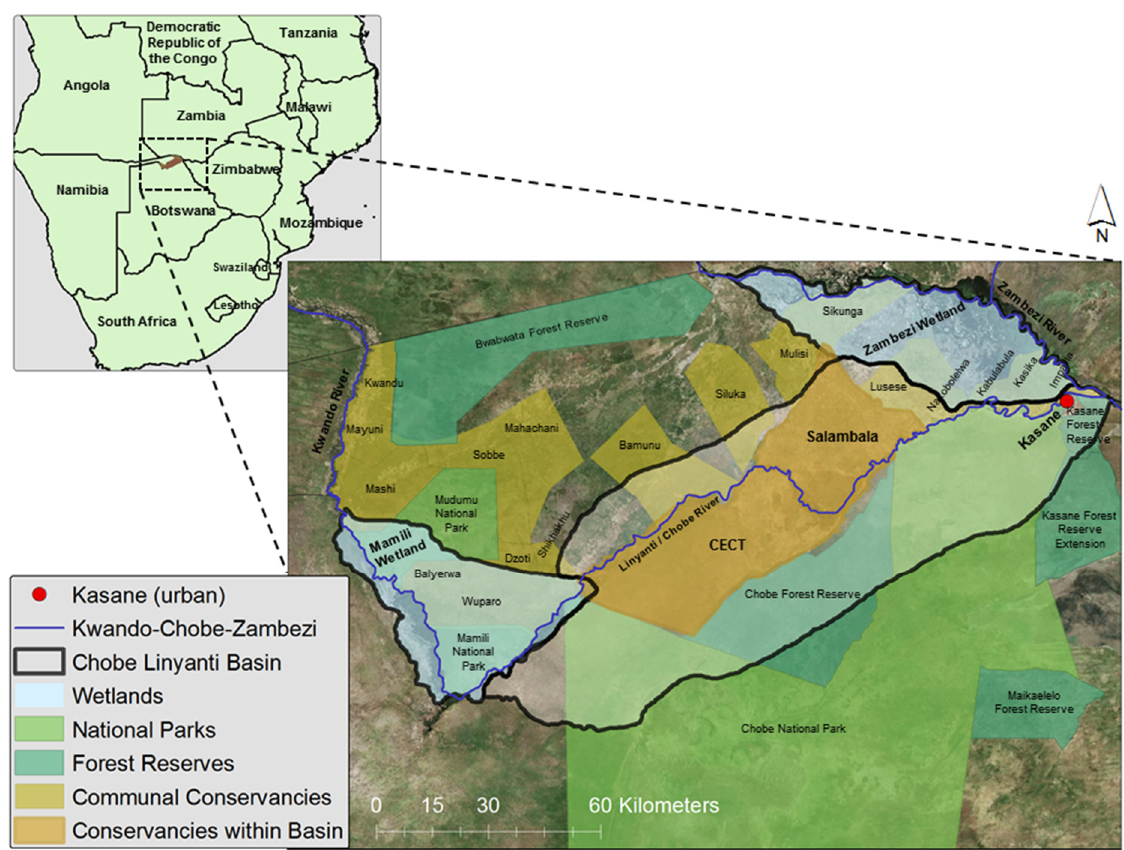
Figure 1. Study area in Southern Africa: Chobe River Basin (made up of the Chobe-Linyanti River basin, Mamili Wetland and Zambezi Wetlands, represented by light blue, transparent polygons) and the main land use categories in the basin, highlighting the Salambala Conservancy (Namibia) and the Chobe Enclave Community Trust (CECT, Botwana) in orange. The Chobe-Linyanti and Kwando rivers mark the boundary between Namibia (to the north) and Botswana (to the